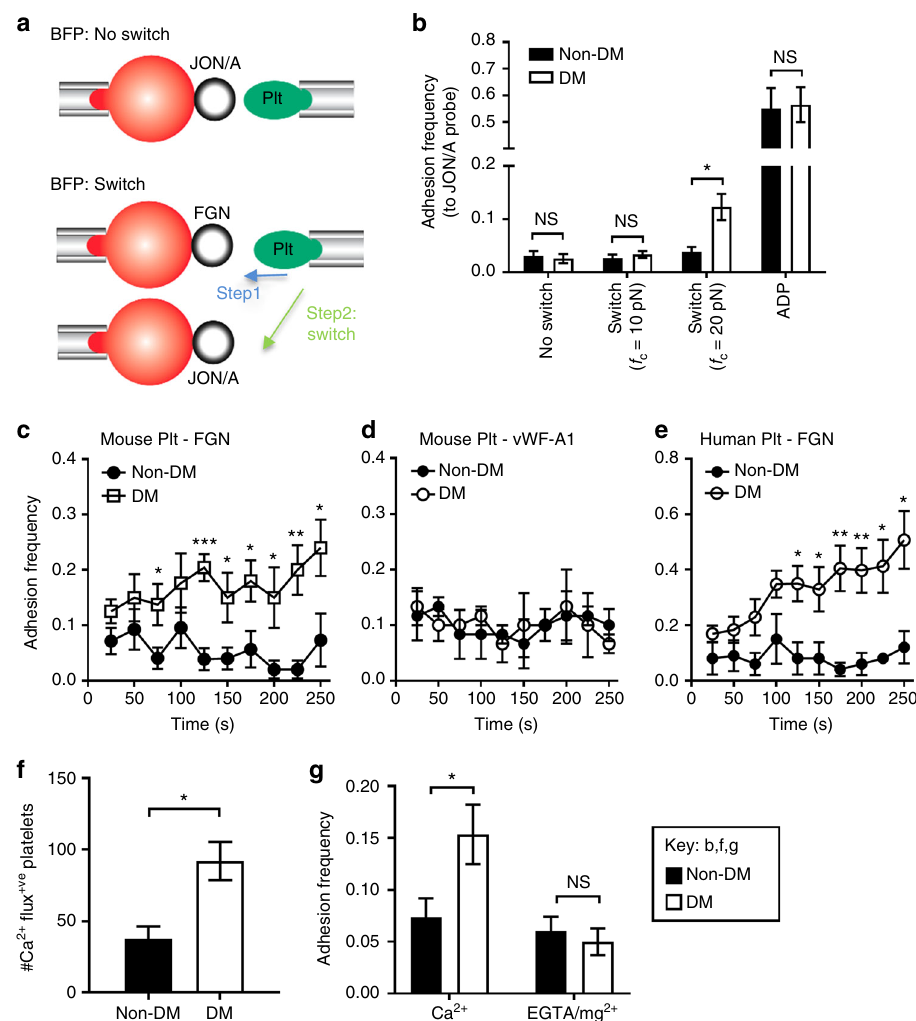
Fig. 6 Compression force-dependent activation of integrin α II b β 3 . a Schematics of ‘ no switch ’ BFP (top) and ‘ switch ’ dual BFP setup (bottom). In the ‘ switch ’ setup, the platelet is fi rst subjected to 50 cycles with a FGN coated bead at a compressive force of 20 pN (step 1), and then switched to 50 cycles with bead coated with JON/A. b Mouse platelet adhesion frequencies with JON/A were determined under conditions of no switch, or switch at the indicated compressive forces ( f c = 10, 20 pN), or ADP stimulation (10 µ M). c – e Non-DM and DM platelets from mice or humans were subjected to 100 BFP cycles at f = 20 pN using FGN ( c , e ) or vWF-A1 ( d ) beads. Adhesion frequency was analyzed for every 10 consecutive cycles and plotted over time (2.5 s/cycle). f c Isolated mouse non-DM and DM platelets were loaded with calcium dyes Oregon Green BAPTA and Fura Red, reconstituted with RBCs from the same mouse, and perfused over FGN matrices at 600 s − 1 . The calcium changes in individual adherent platelets were monitored and the number of adherent platelets displaying Ca 2 + fl ux analysed. g Non-DM and DM mouse platelets were resuspended in Tyrode ’ s buffer containing 1 mM Ca 2 + or 1 mM EGTA/ Mg 2 + , subjected to 50 BFP cycles using FGN-beads at f c = 20 pN, and adhesion frequency determined. All results are expressed as the mean ± s.e.m. of n = 3 mice and assessed by unpaired, two-tailed Student ’ s t -test, where * p < 0.5; ** p <